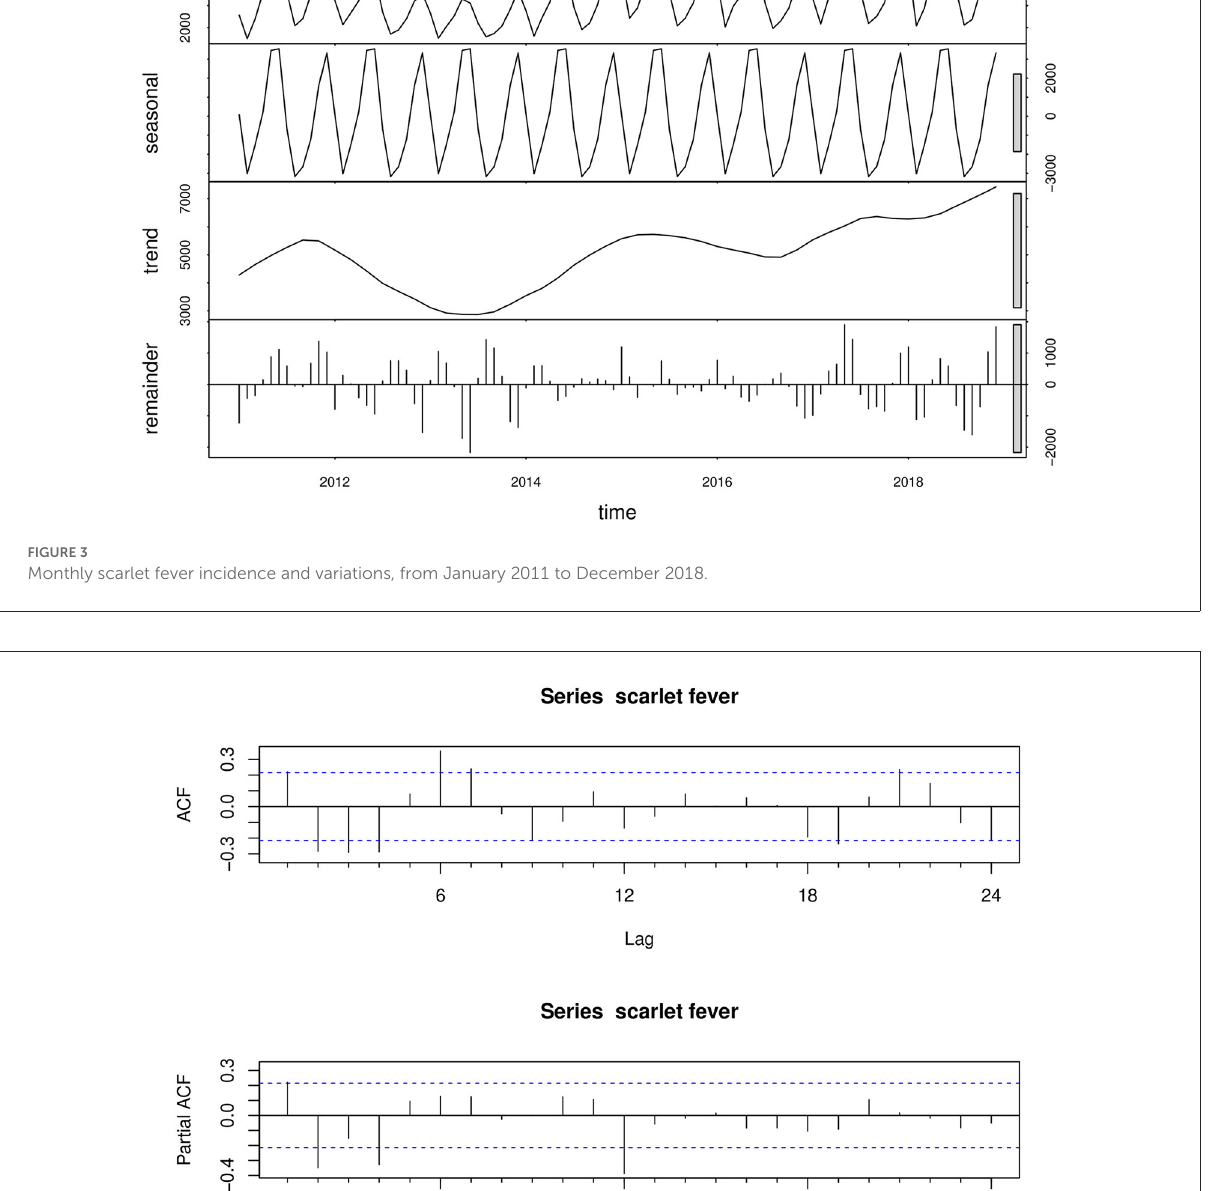
a flat trend. We also found that the dual seasonality of scarlet fever during COVID-19 pandemic was no longer prominent,